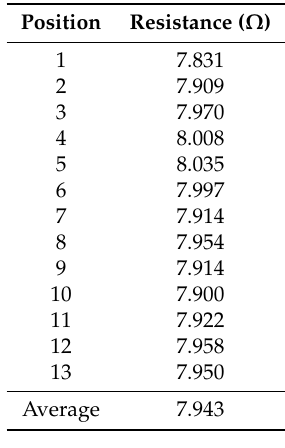
Figure 1. Schematic positions on indium-tin oxide (ITO) film placed on a glass slide for sheet resistance (Rs)/square measurement. Table 1. Rs/Square Measurements Obtained on ITO Film.